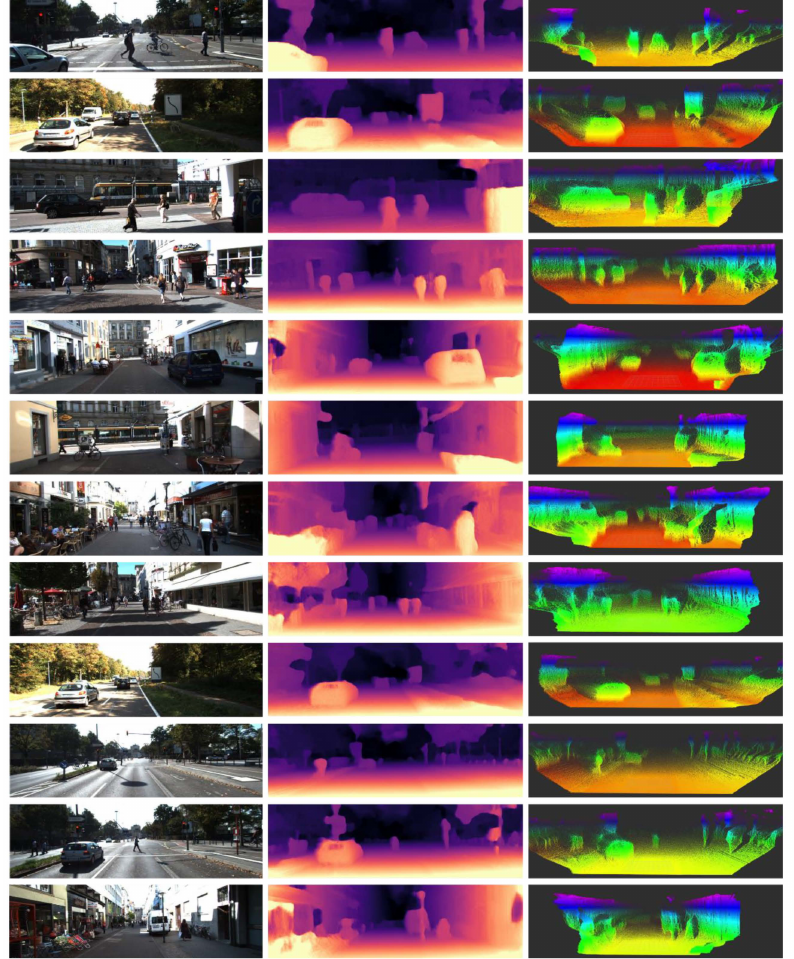
Figure 5. Visualization of point cloud generated from the depth estimation; the first column is the input pairs to the neural network, the second column is depth prediction, and the third column presents the point cloud